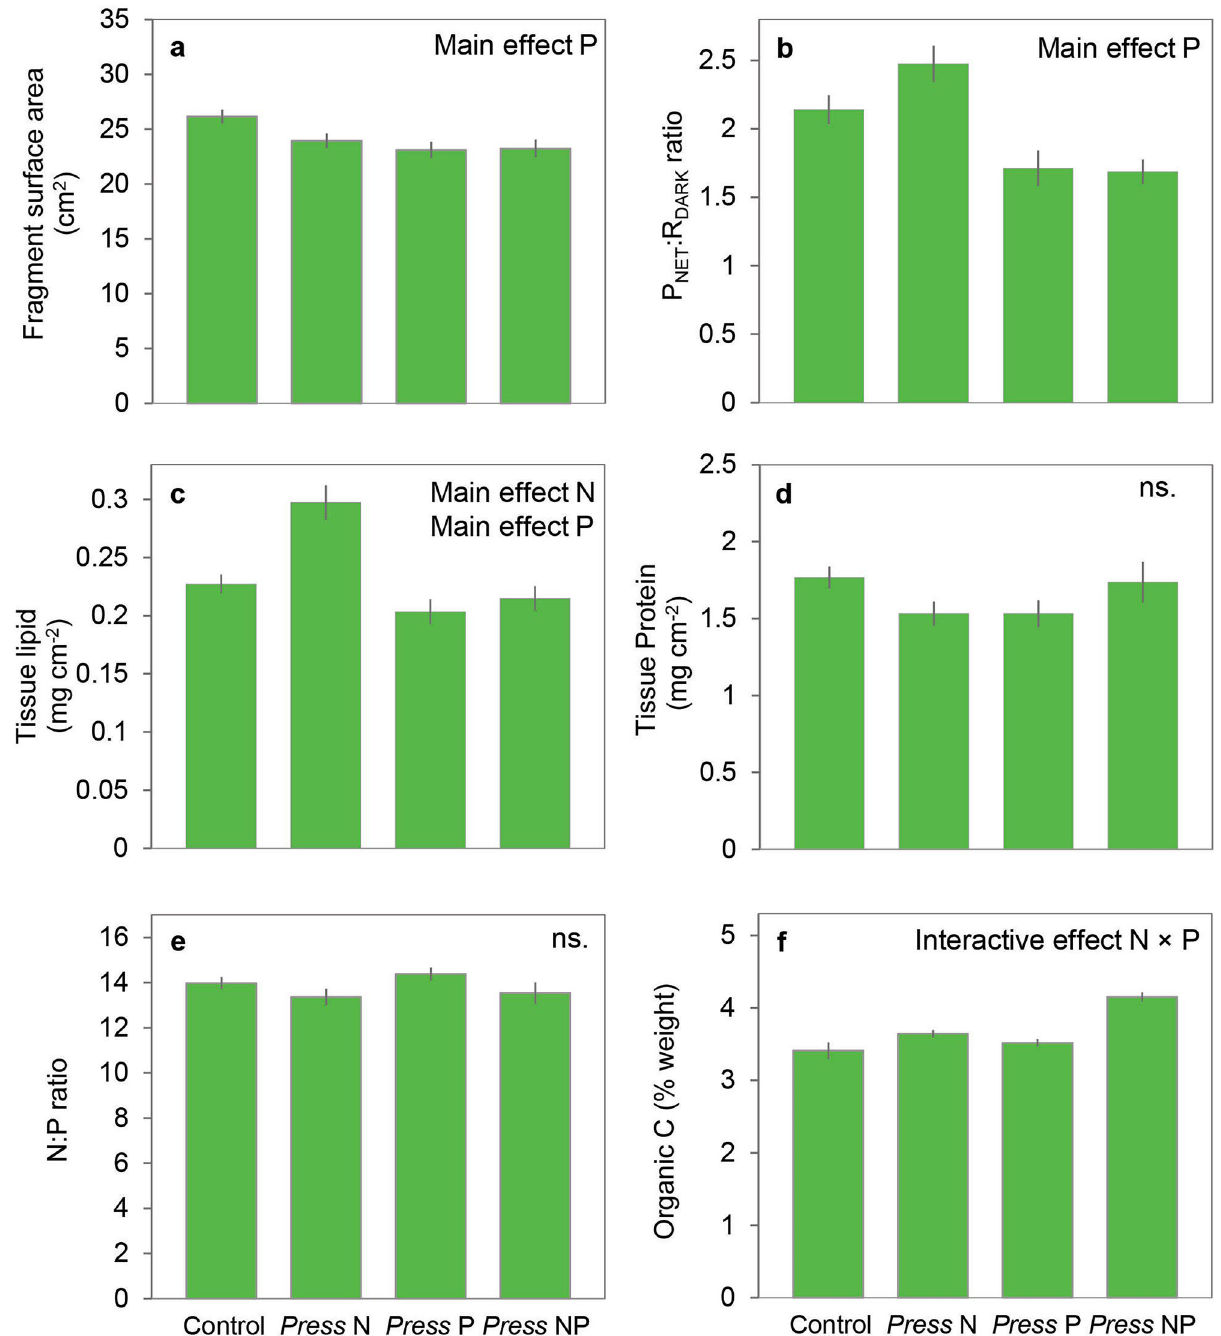
Figure 2. Metrics of coral physiology (mean ± SE) of Acropora intermedia fragments after 7-week exposure to elevated ammonium (N) and/or phosphate (P) under an orthogonal design. Fragment surface area (n = 16) was measured at the end of the experiment ( a ). Net photosynthesis (P NET ) to dark respiration (R DARK ) ratios (n = 12) were obtained from oxygen flux measurements ( b ), and total tissue protein ( c ) and lipid ( d ) concentrations (n = 12), and tissue N:P ratio ( e ) and organic carbon ( f ) content (n = 4) were measured from tissue samples collected at the end of the